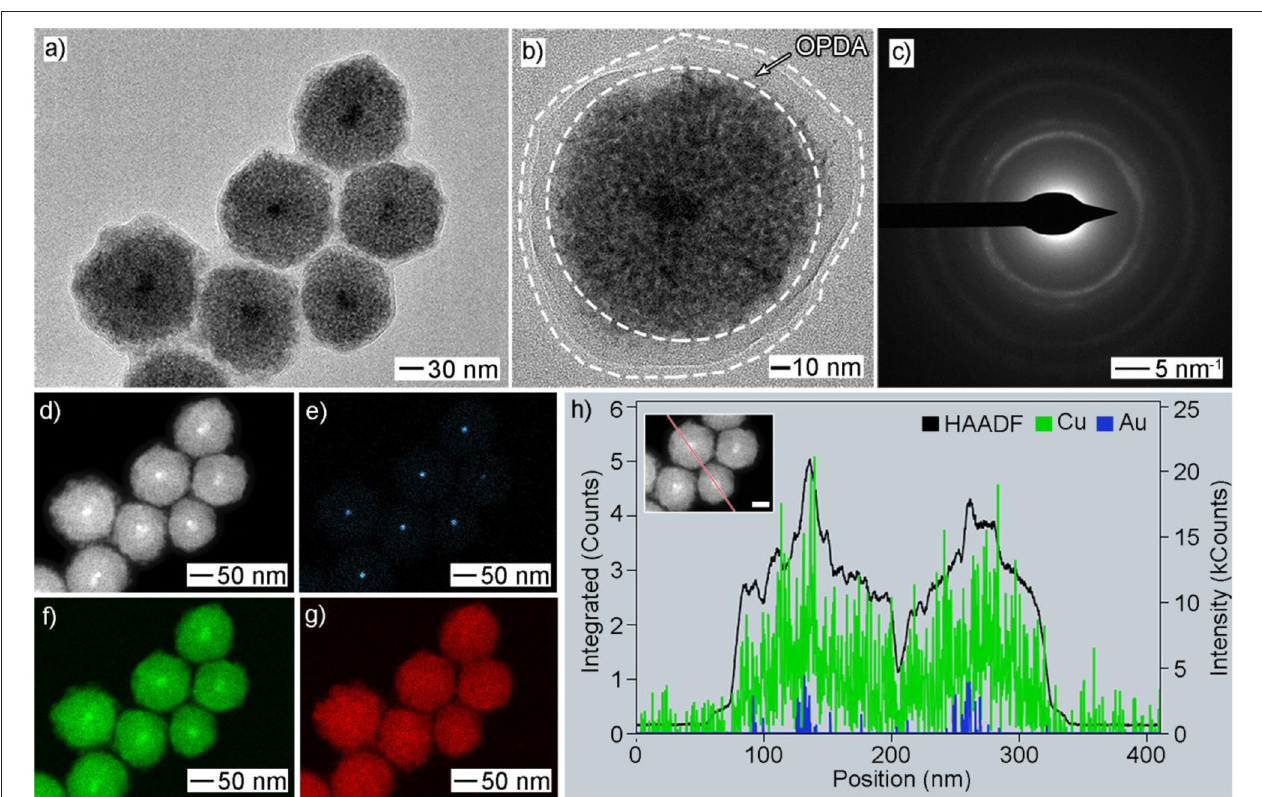
FIGURE 3 | Morphology and structural characterizations of Au@Cu x O core–shell MPNSs as displayed in Figure 1c : (a,b) TEM, (c) ED, (d) HAADF-STEM, (e–g) EDX-mapping: (e) Au, (f) Cu, (g) O; (h) line-scan spectrum. The inset in (e) shows a corresponding particle with a scale bar of 50nm.